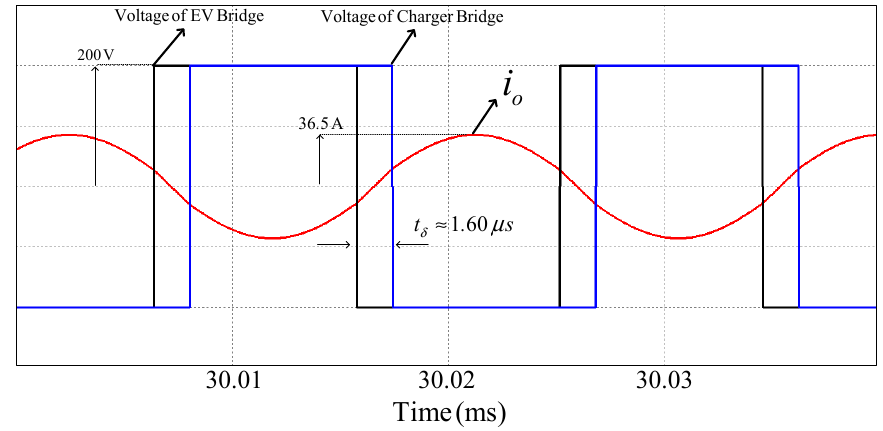
Figure 10. Output voltage of charger bridge, EV bridge and i o under equal voltages condition with τ 1 = 10µs and τ 2 = 1µs while the power is in backward direction.